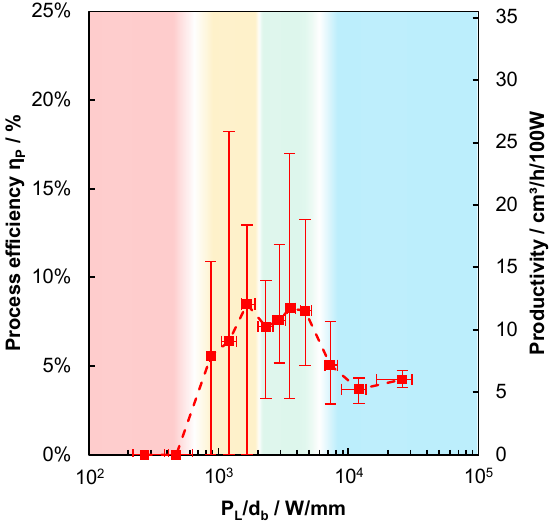
Figure 5. Experimentally determined process efficiency (1) and productivity (2) as a function of P L / d b . Red-colored area: complete failure of the additive process with η P = 0. Yellow-colored area: occasional failure of the additive process with minimum values of the error bars at 0% of η P . Green-colored area: reproducible additive process with efficiencies always >0% in all experiments. Blue-colored area: reproducible additive process with average efficiencies <5%, but always >0%. Between P L / d b = 5200 W/mm and P L / d b = 7200 W/mm, the process efficiency